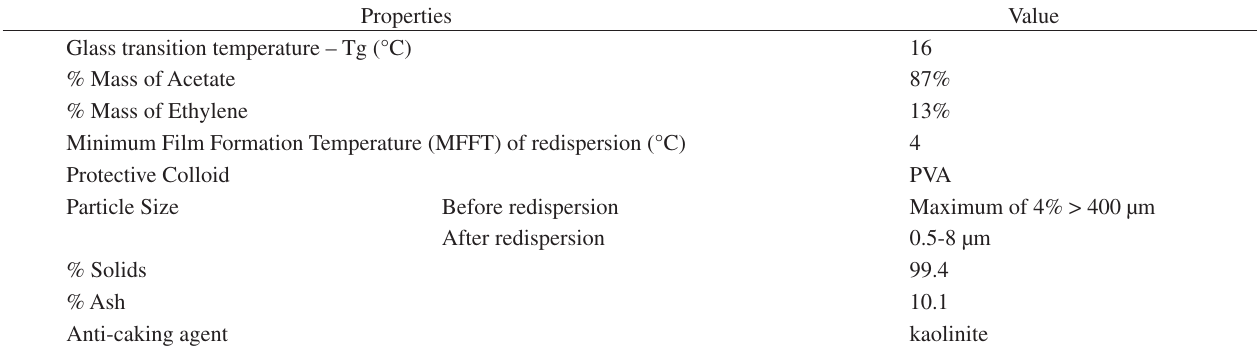
Table 3. Characteristics of EVA redispersible polymer